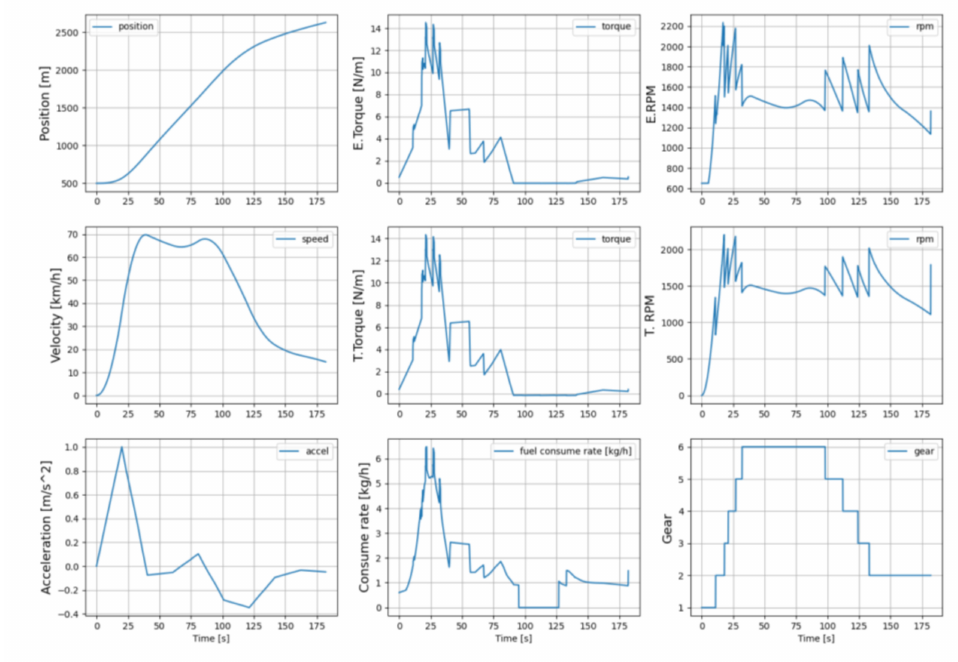
Figure 12. Detailed analysis on the best trip in the three